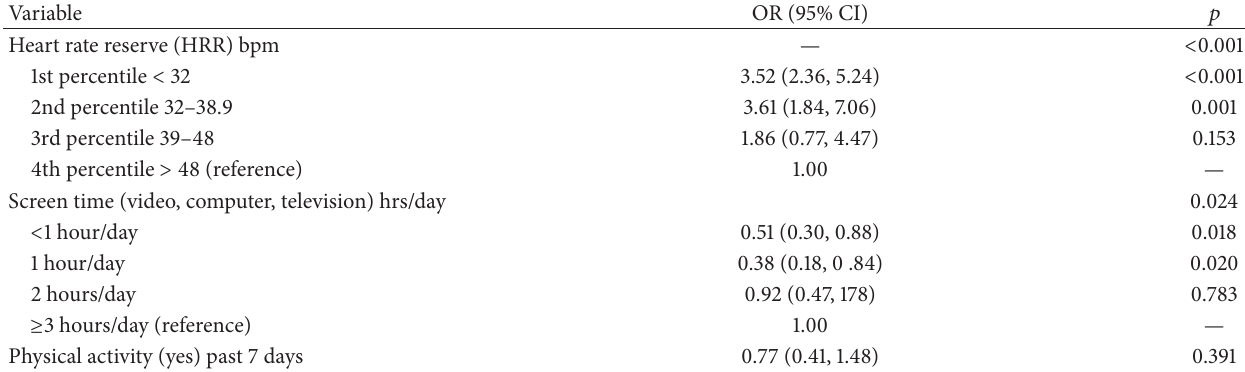
Table 3: Odds ratio overweight/obesity versus under/normal weight by age and sex